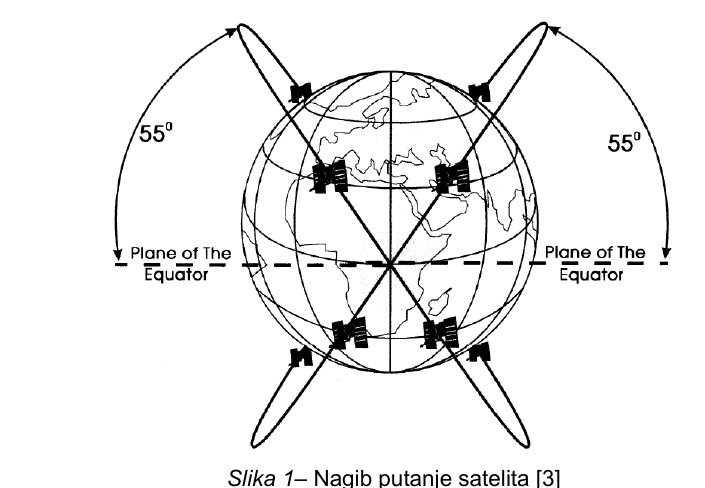
Sistem GPS danas sadrži 31 satelit koji su raspore đ eni u šest polar- nih, skoro kružnih orbita (po č etiri satelita u svakoj) sa nagibom putanje i = 55º prema ekvatoru i me đ usobnim razmakom orbita od 60º po geograf- skoj dužini (slika 1). Sadašnju konstelaciju GPS č ine 13 satelita Blok II A,